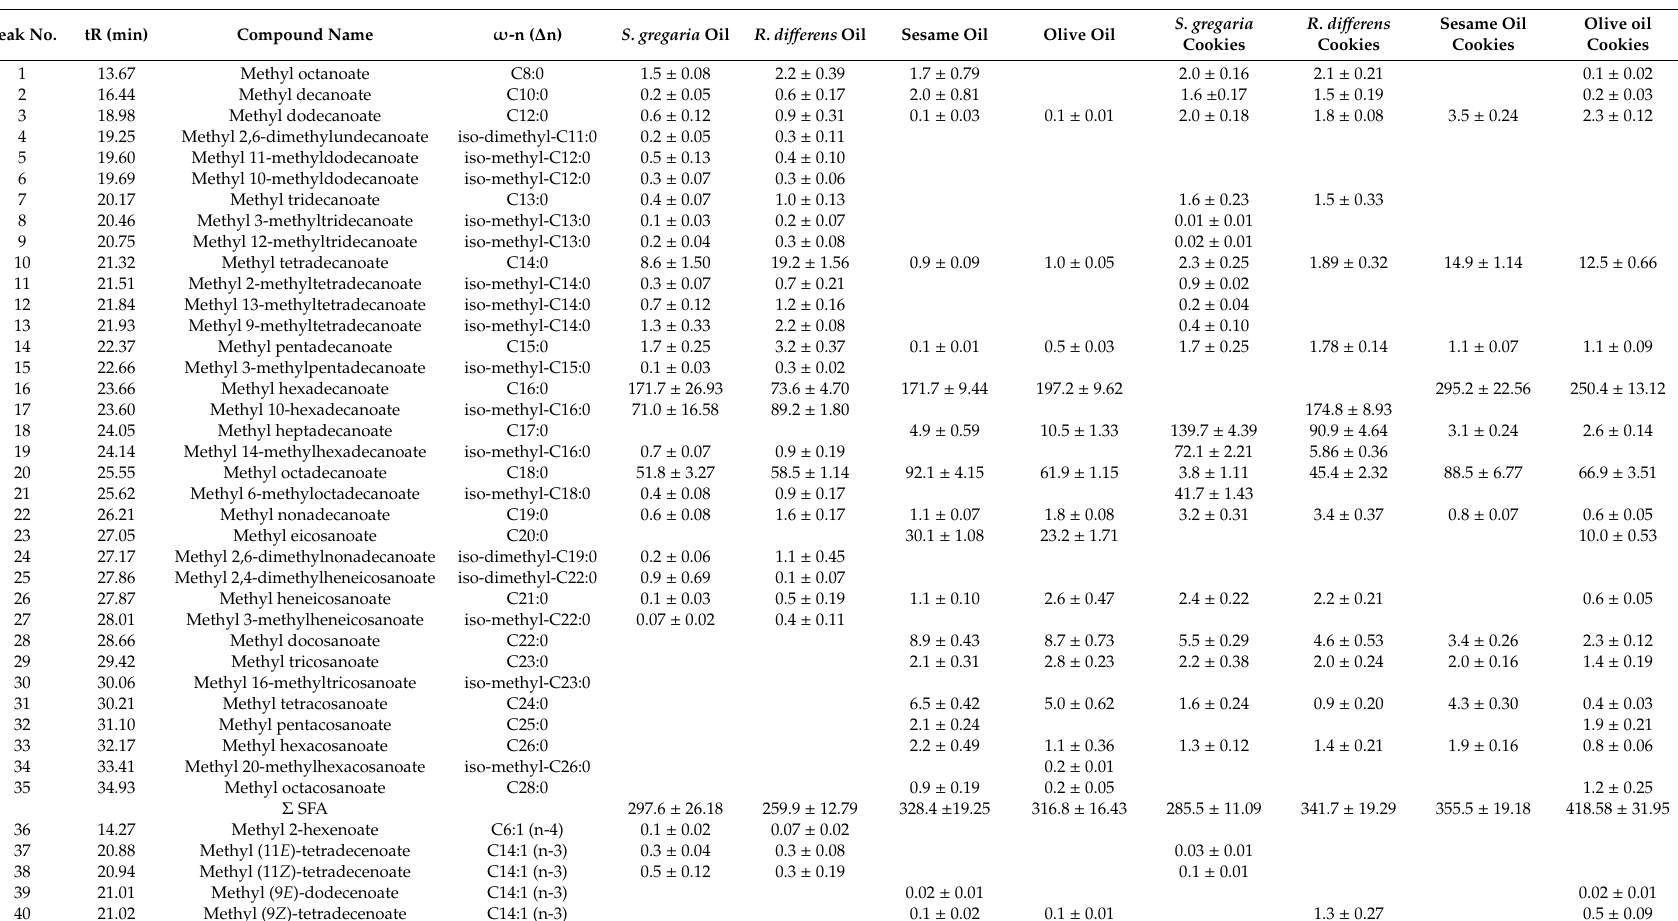
Table 1. Fatty acid composition ( µ g / mg of oil and cookies a ) made from di ff erent plant and insect oils analyzed by Gas Chromatography coupled to Mass Spectrometry (GC-MS). Peak